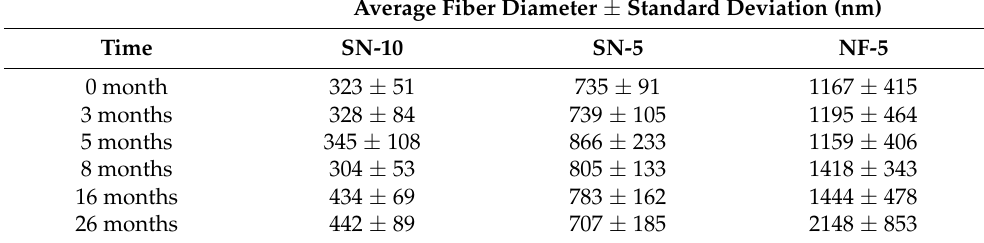
Table 6. Average fiber diameters of nanofibers produced using nozzle-based (SN) and nozzle-free (NF) electrospinning during the 26-month stability